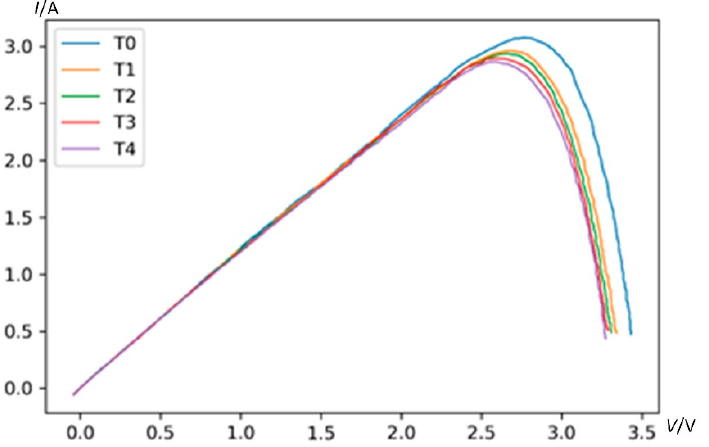
Figure 26. P-V curves of a mini-PV module of six cells at different temperatures. T 0 < T 1 < T 2 < T 3 < T 4 .